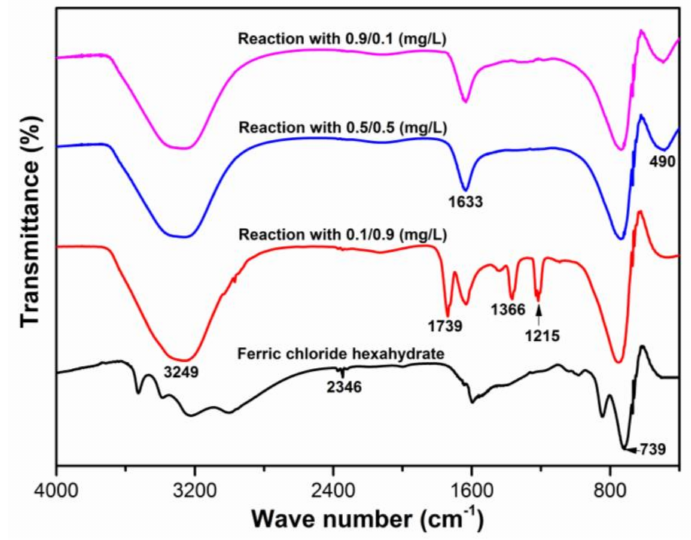
Figure 5. The Fourier transform infrared (FT–IR) spectra of ferric chloride hexahydrate before and after reaction with Sb(III)/Sb(V) proportions of 0.1/0.9 (mg/L), 0.5/0.5 (mg/L), and 0.9/0.1 (mg/L) solutions at pH 7 (the solution pH was adjusted using 0.1M HCl and 0.1M NaOH